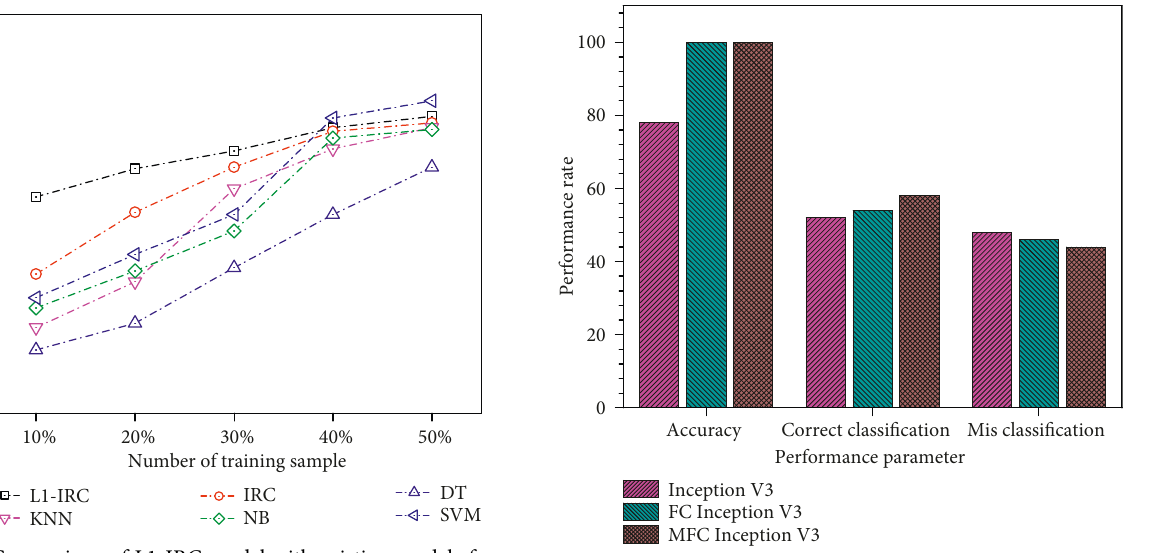
Figure 6: Accuracy, classification, and misclassification rate of different models with MFC inception